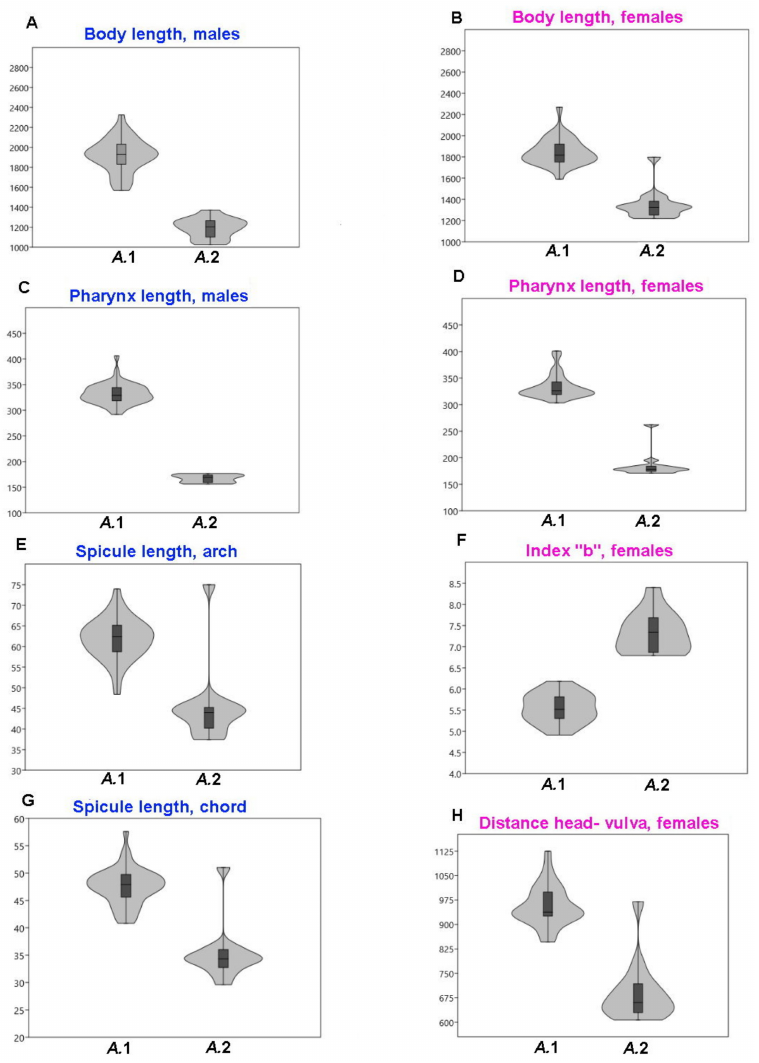
Figure 4. The examples of the solitary characters analyses of the two assemblages of males ( left ) and females ( right ) from samples PA13 and PA21 belonging to groups Acanthopharynx 1 ( A .1) and Acanthopharynx 2 ( A .2): ( A ) Body length, males; ( B ) Body length, females; ( C ) Pharynx length, males; ( D ) Pharynx length, females; ( E ) Spicule length, arch; ( F ) Index “b”, females; ( G ) Spicule length, chord; ( H ) Distance head—vulva,